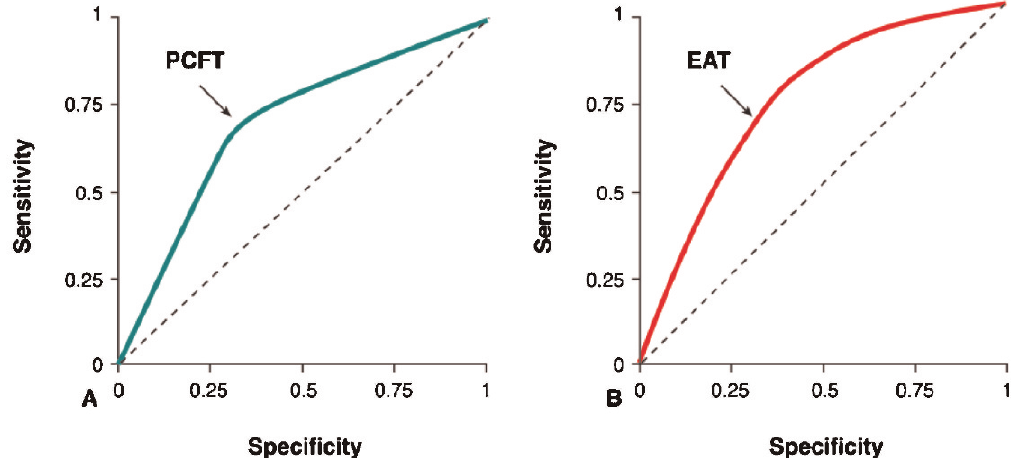
Figure 3 - A) ROC curve for PCFT for the development of obstructive coronary artery disease (OCAD). A ROC curve for OCAD was plotted to verify the optimum cut-off point for PCFT, which was 13.8 mm. The AUC for PCFT was 71.4% (95%CI, 0.665-0.764), with a sensitivity of 72.2% and a specificity of 68.1%. B) ROC curve for EAT for the development of OCAD. A ROC curve for OCAD was plotted to verify the optimum cut-off point for EAT, which was 6.8 cm. The AUC for PCFT was 71.5% (95%CI, 0.750-0.777), with a sensitivity of 73.5% and a specificity of